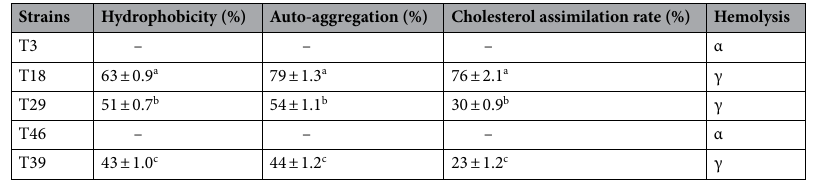
Table 2. Results of hydrophobicity, auto-aggregation, cholesterol assimilation rate, and hemolysis. Values are mean ± standard deviation of triplicates. a–c Means in the same column with same lowercase letters are not differed significantly ( p ≤ 0.05).